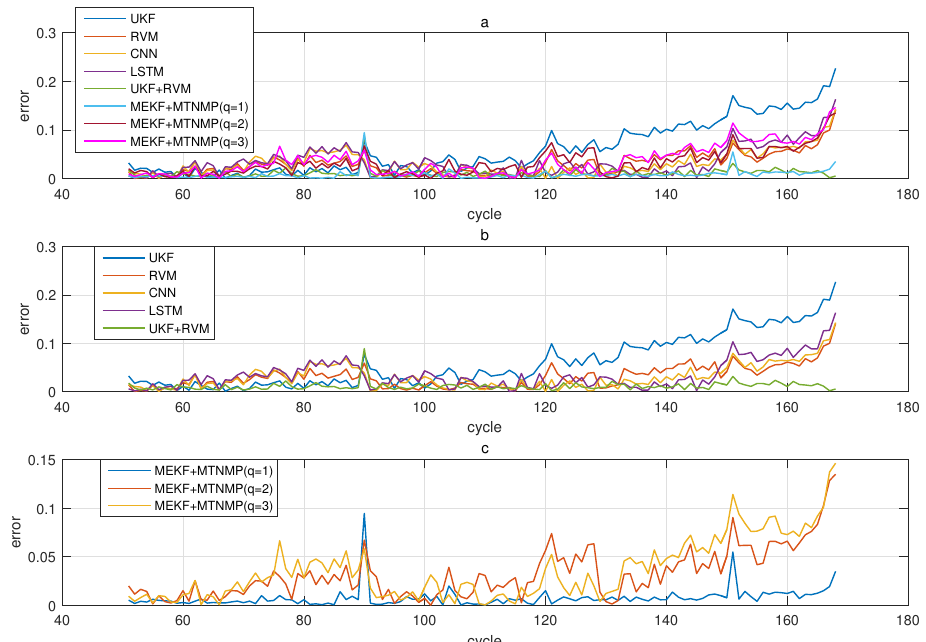
Figure 5. The simulation error diagram of B0005 predicted from the 50th time. ( a ) is the experimental error of all methods, ( b ) is the error of other methods used for comparison in ( a ), and ( c ) is the error of the method proposed in this paper in ( a ).